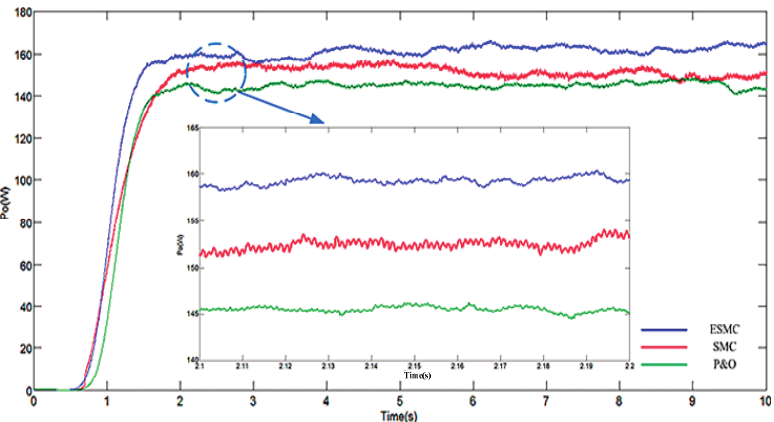
Figure 14. Rotation speed ω (rad/s).